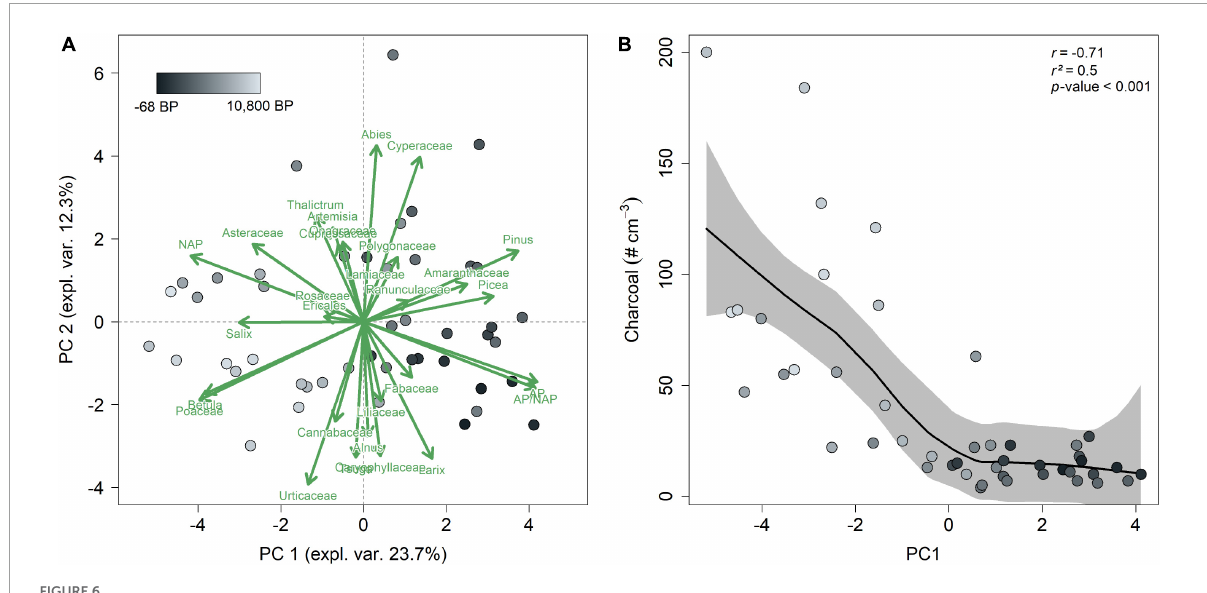
FIGURE6 (A) Principal component analysis of REVEALS-transformed vegetation types. (B) Scatterplot of macroscopic charcoal concentration and principal component 1 (PC1) of the PCA, with